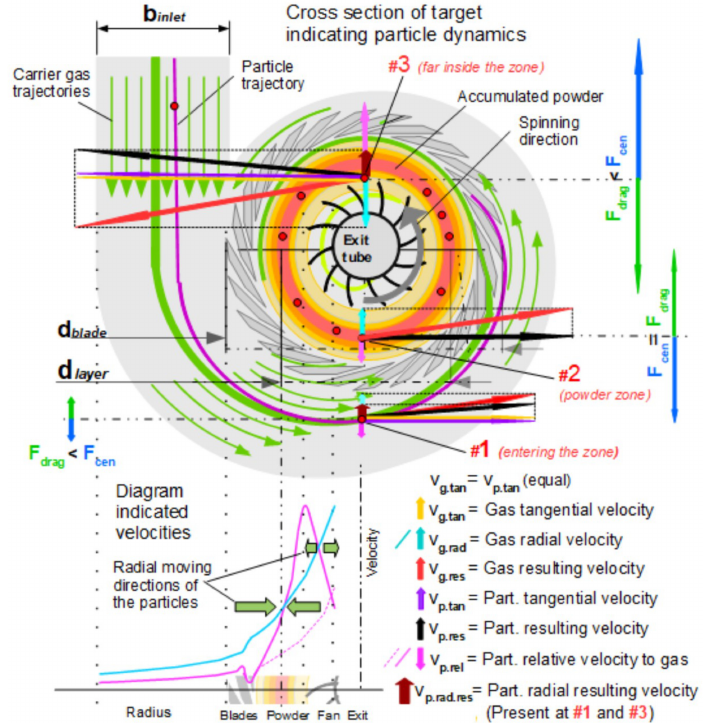
Figure 2. Illustrations of the gas trajectories by (curved) green arrows of equal lengths in the housing. The three positions labeled #1, #2, and #3 describe the locations that are outside, inside, and “too far” inside the powder presence zone. The diagram shows that the radius depends on velocity trends for the gas and the particles. Obviously, the particle relative velocity (pink line) rises beyond the radial gas velocity (blue